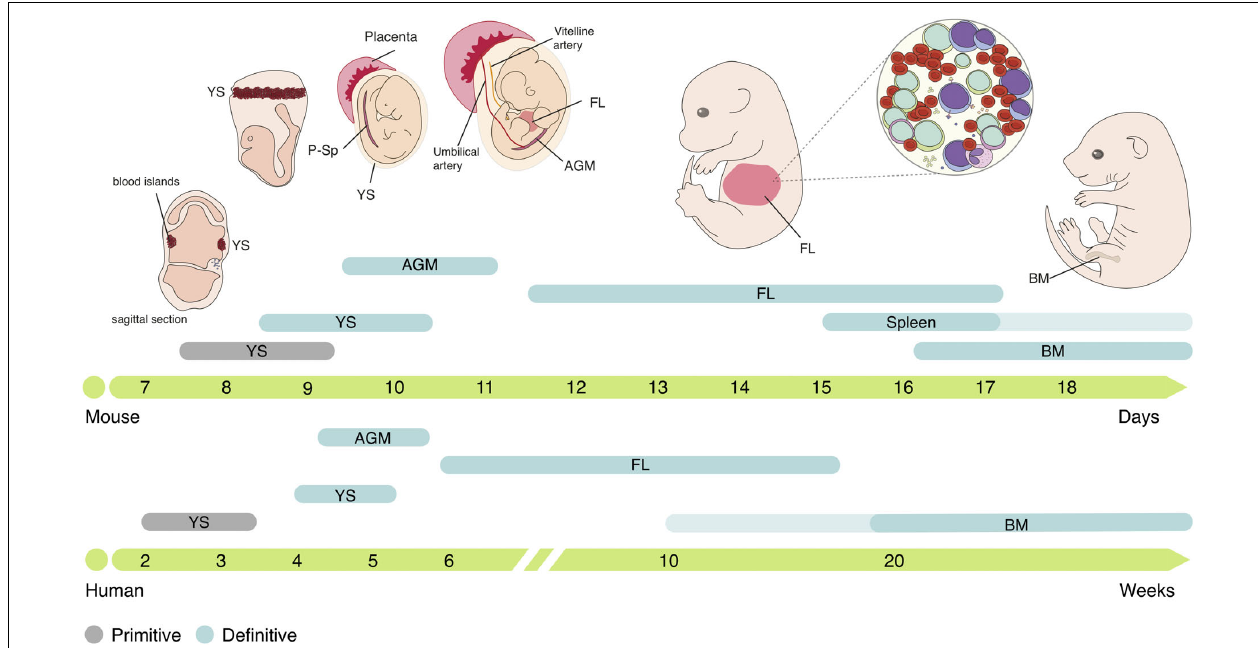
FIGURE 1 | Ontogeny of the hematopoietic system in mouse and human. Embryonic hematopoiesis is established in three distinct waves. The first hematopoietic cells emerge in YS blood islands, generating primitive erythrocytes, macrophages and megakaryocytes, constituting the primitive hematopoietic wave. The second hematopoietic wave initiates in the vascular plexus of the YS, generating EMPs that produce definitive erythrocytes, megakaryocytes, macrophages, neutrophils, granulocytes and mast cells, but lacks HSC activity. EMPs are the origin of tissue-resident macrophages that can persist throughout life. HSCs emerge in the AGM region and migrate to the FL, the major embryonic hematopoietic organ. In FL, HSCs expand and differentiate into all mature blood cell lineages. Small numbers of hematopoietic progenitors also colonize the fetal spleen and are still found few weeks after birth. Migration to the BM, where HSCs reside through adulthood, occurs as a continuous process and, in humans, can take several weeks. YS, yolk sac; P-Sp para-aortic splanchnopleura; FL, fetal liver; AGM, aorta-gonads-mesonephros; BM, bone marrow.